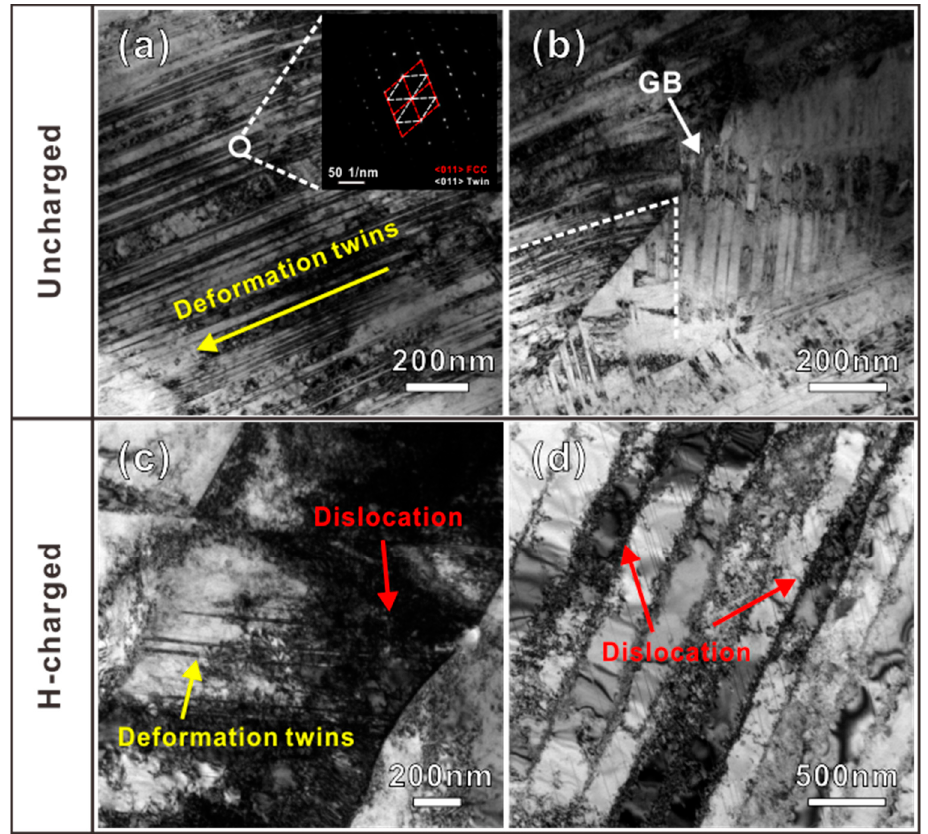
Figure 8. TEM images of the tensile deformation microstructures of ( a , b ) uncharged sample and ( c , d ) H ‐ charging sample.